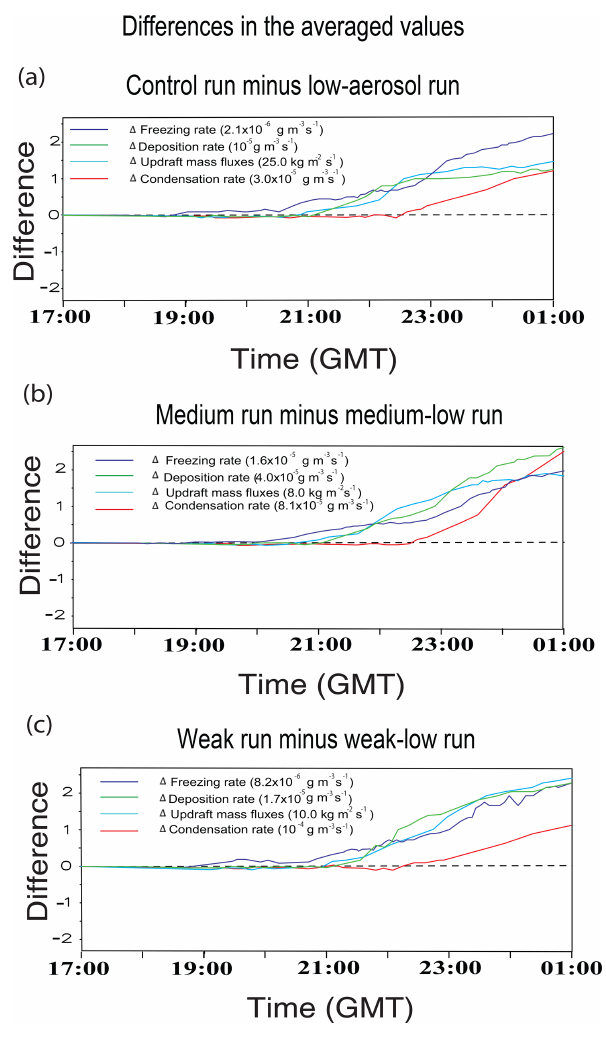
Figure 10. Time series of differences in average values of variables related to aerosol-induced invigoration of convection at all altitudes in cloudy areas between the (a) control and low-aerosol runs for strong fire intensity, (b) medium and medium-low runs for medium fire intensity and (c) weak and weak-low runs for weak fire